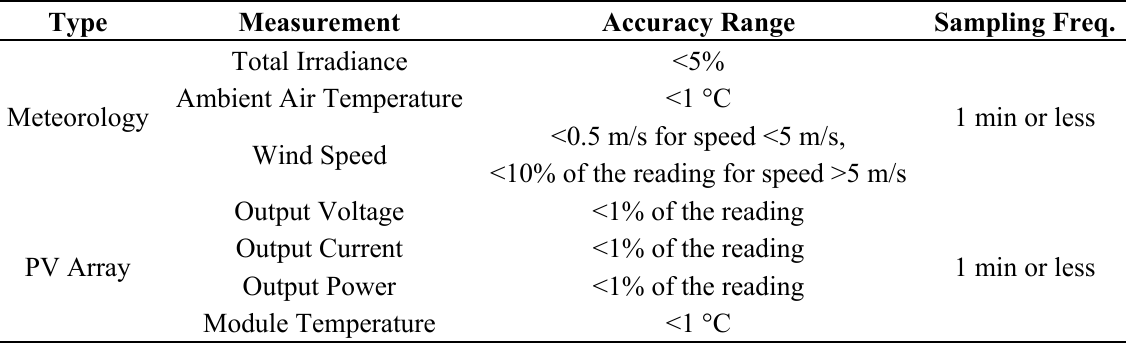
Table 3. Monitoring parameters of a PV system based on IEC 61724.